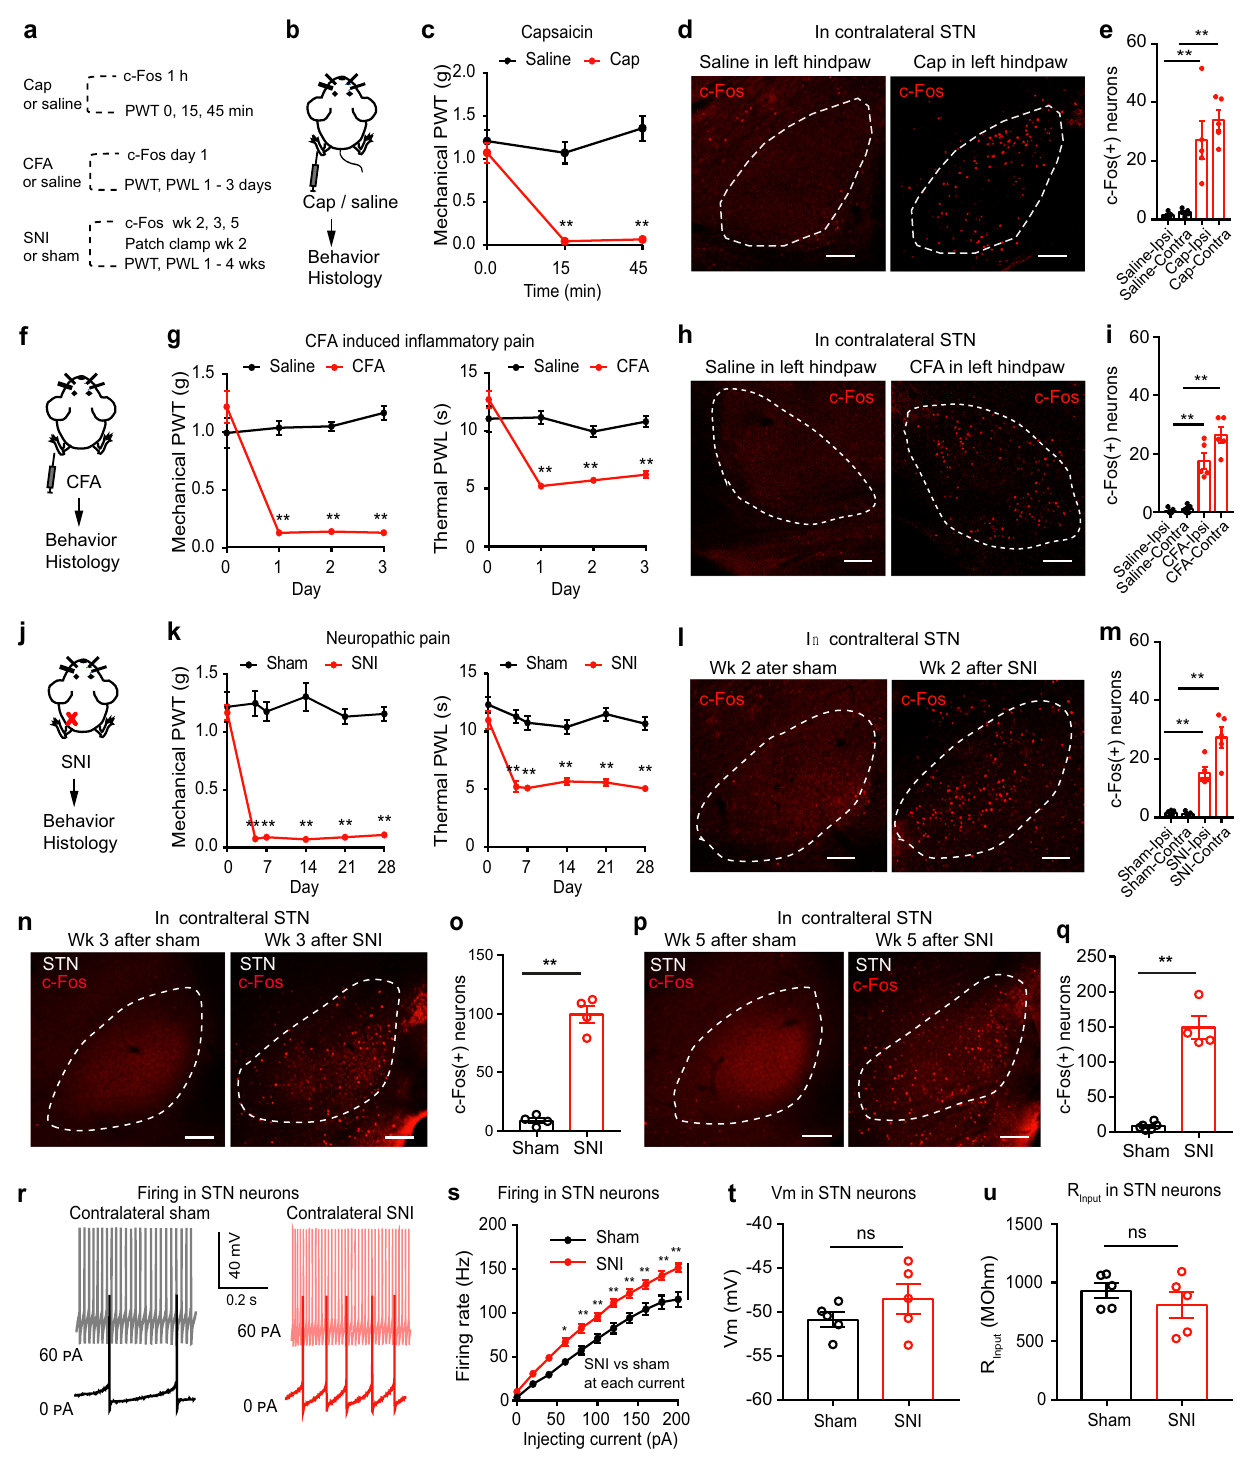
Fig.1|STNneuronsareactivatedinpain-likebehaviors.a Experimentaldiagram. b , c Pain development evoked by capsaicin. c PWT: F (2, 36) = 16.62, P <0.001; n =7 per group. d , e Example images ( d ) and quanti fi cation ( e ) of c-Fos-positive neuron after saline or capsaicin (Cap). F (3, 16) = 20.09, P <0.0001; n =5 per group. f , g Pain developmentafterCFAinjection.PWT: F (3,44) =29.31, P <0.001;PWL: F (3,44) =17.67, P <0.0001; n ≥ 6 per group. h , i Example images ( h ) and quanti fi cation ( i ) of c-Fos- positive neurons after saline or CFA. F (3, 16) = 42.17, P <0.0001; n =5 per group. j , k PaindevelopmentafterSNI. k PWT: F (5,78) =21.23, P <0.0001;PWL: F (5,78) =6.12, P <0.0001; n ≥ 7pergroup. l , m Exampleimages( l )andquanti fi cation( m )ofc-Fos- positive neurons in week 2 after sham or SNI ( F (3, 16) = 37.97, P <0.0001; n =5 per